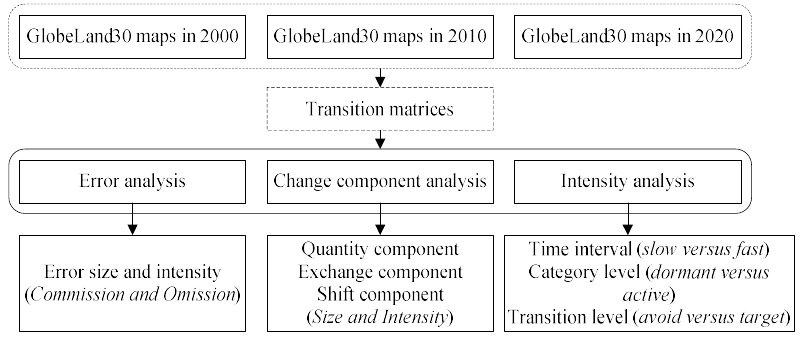
Figure 2. Schematic representation of the main methods followed in this study. At the time interval scale, the observed change intensity during year t to year t + 1 was calculated by Equation (1). The uniform change intensity during all time intervals was calculated by Equation (2).